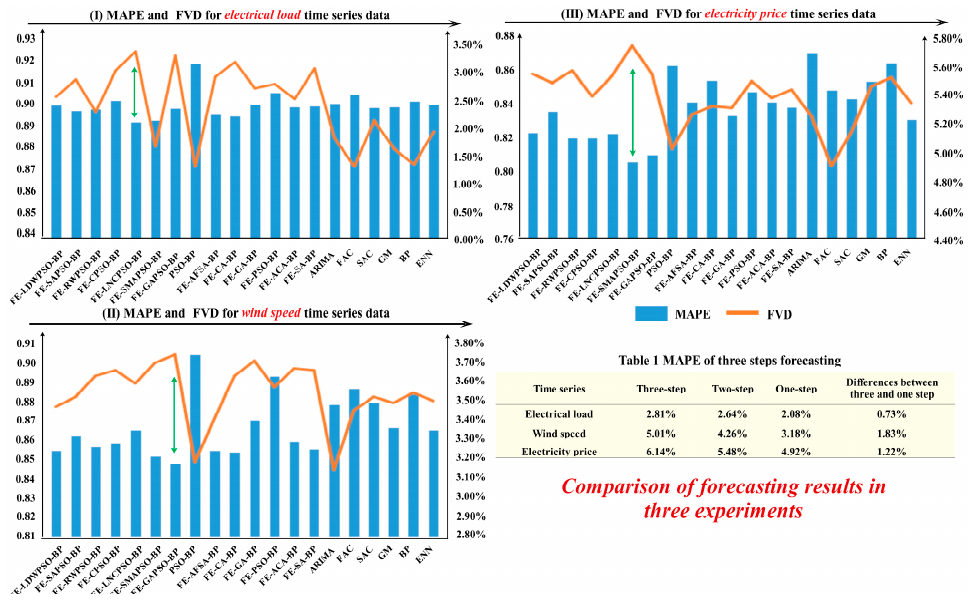
Figure 5. Comparison of forecasting results in three experiments.